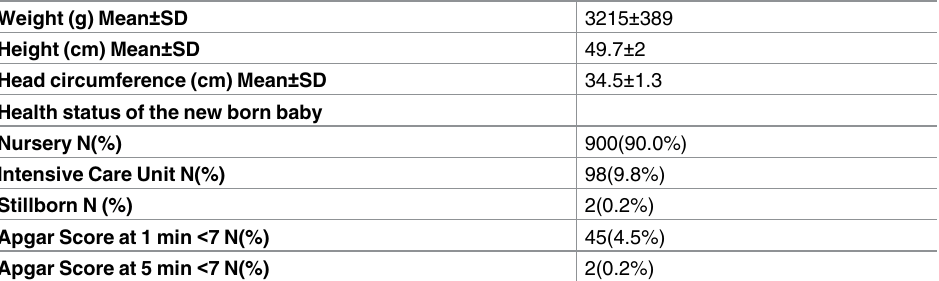
Table 4. General characteristics of infants (N = 1000).